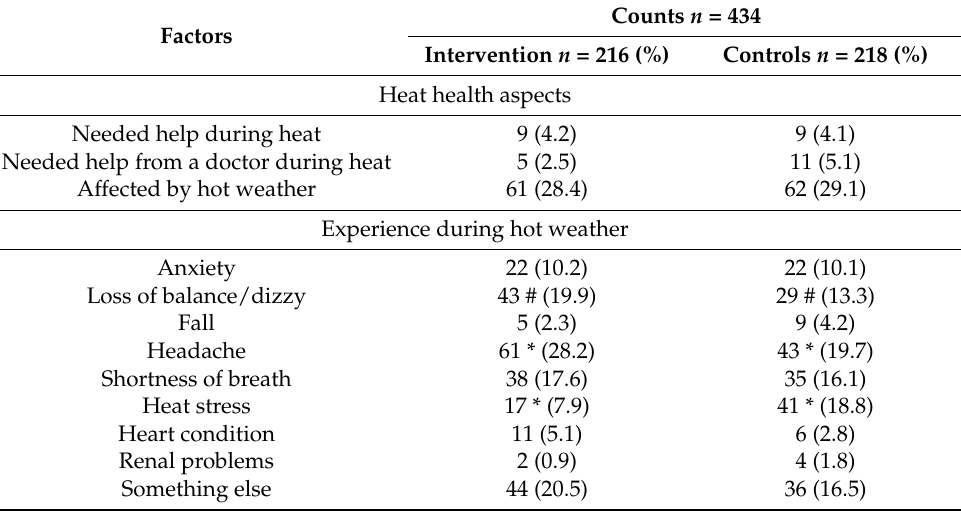
Table 4. Assessment of the frequency distribution of health outcomes during extreme heat by intervention and control